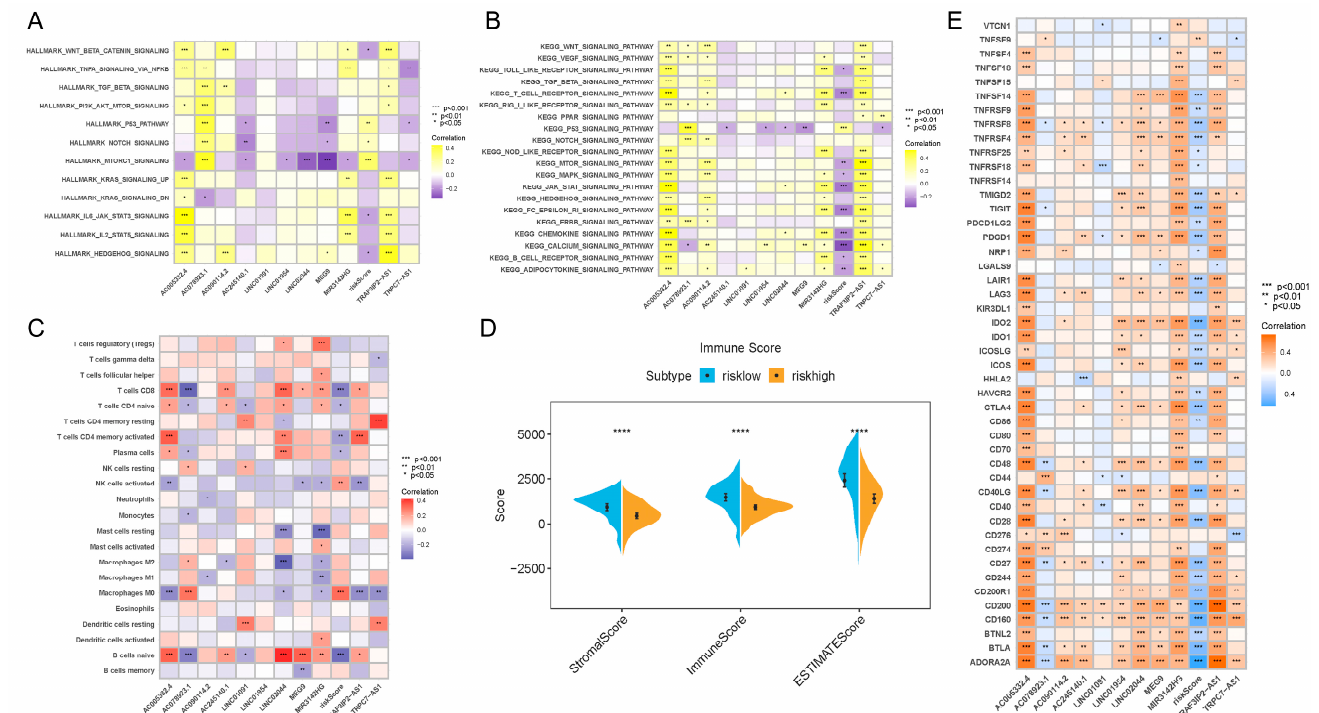
Figure 4. Results of enrichment analysis, TIME feature description and immunotherapy guidance using risk score signature. ( A ) Heatmap showing the representative pathway terms from Hallmark enriched in each m6A lncRNA and the risk score. ( B ) Heatmap showing the representative pathway terms from KEGG enriched in each m6A-lncRNA and the risk score. ( C ) Heatmap showing the significant positive and negative correlations between risk score and multiple infiltrative immune cells in PDAC lesions. ( D ) Results of the ESTIMATE algorithm demonstrating that patients with different risk scores were significantly different in terms of stromal score, immune score and ESTIMATE score. ( E ) Heatmap presenting the negative correlation between risk score signature and immune checkpoint gene expression in PDAC. **** p < 0.0001.